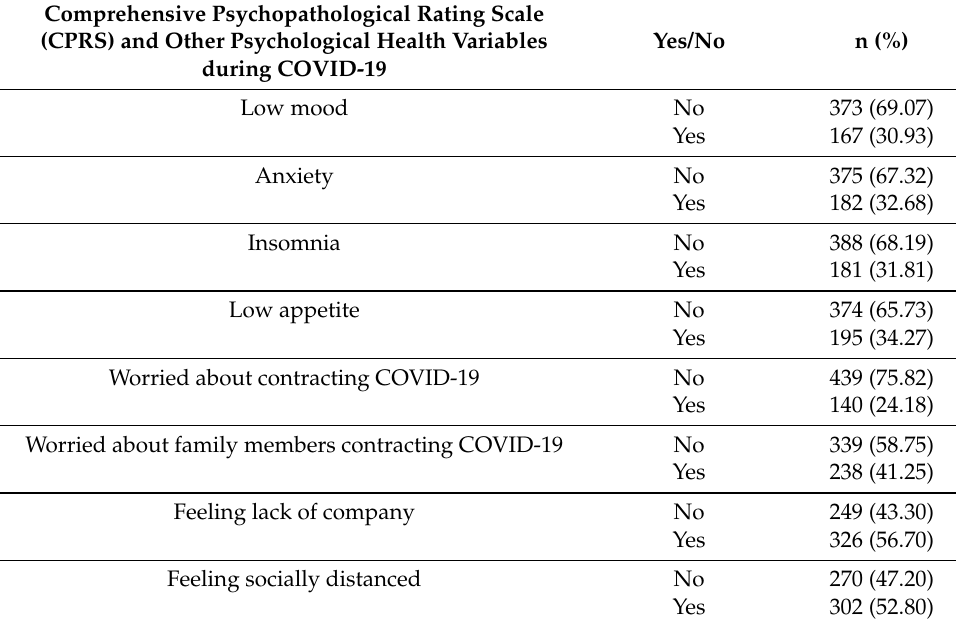
Table 2. Characteristics of the sample in terms of psychological health